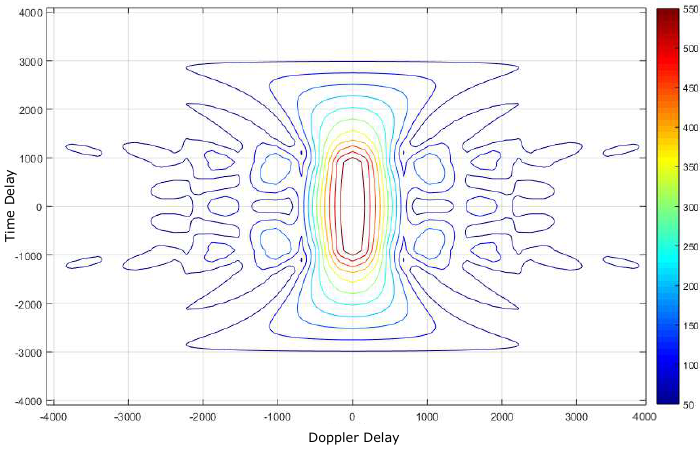
Figure 15. Two closer scatterers using square pulses: 2D, with no noise.